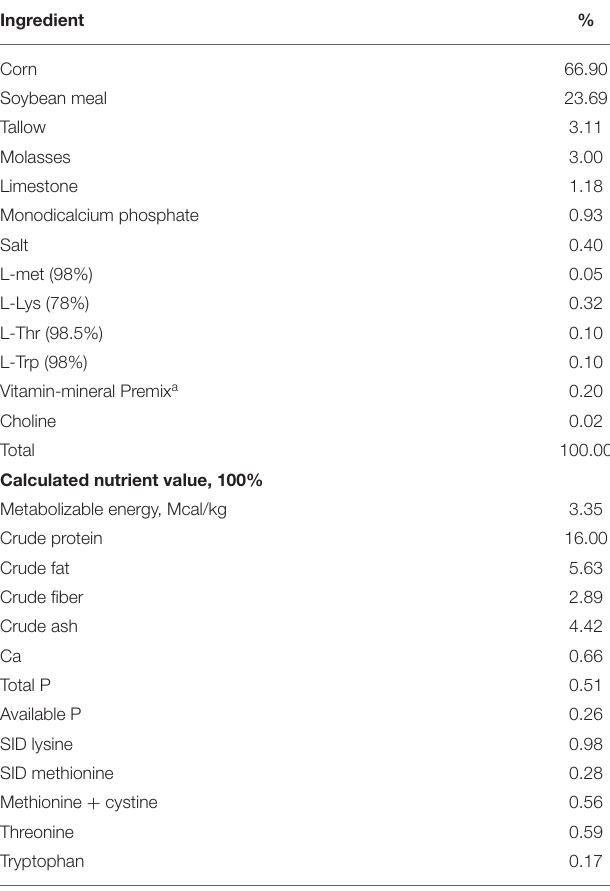
TABLE 1 | Ingredients and nutrient level of basal diet (as-fed basis).